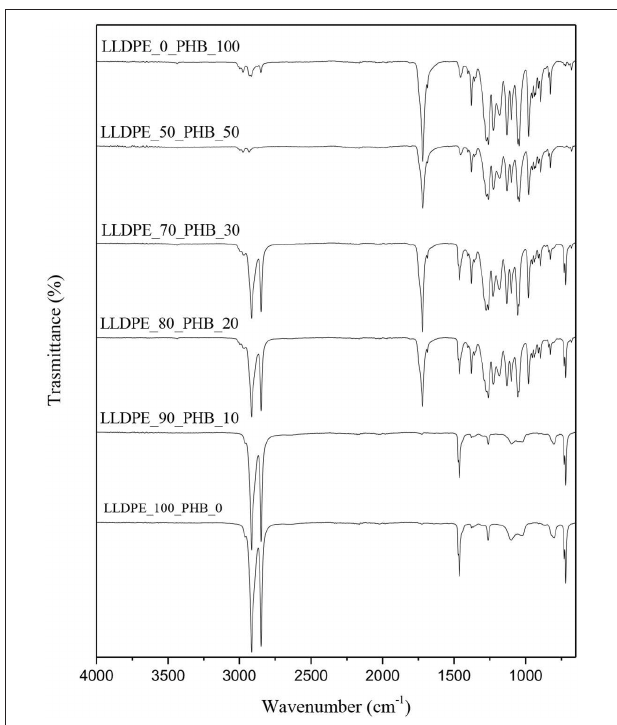
FIGURE 3 | FT-IR spectra of neat LLDPE, neat P(3HB), and relative LLDPE/P(3HB)